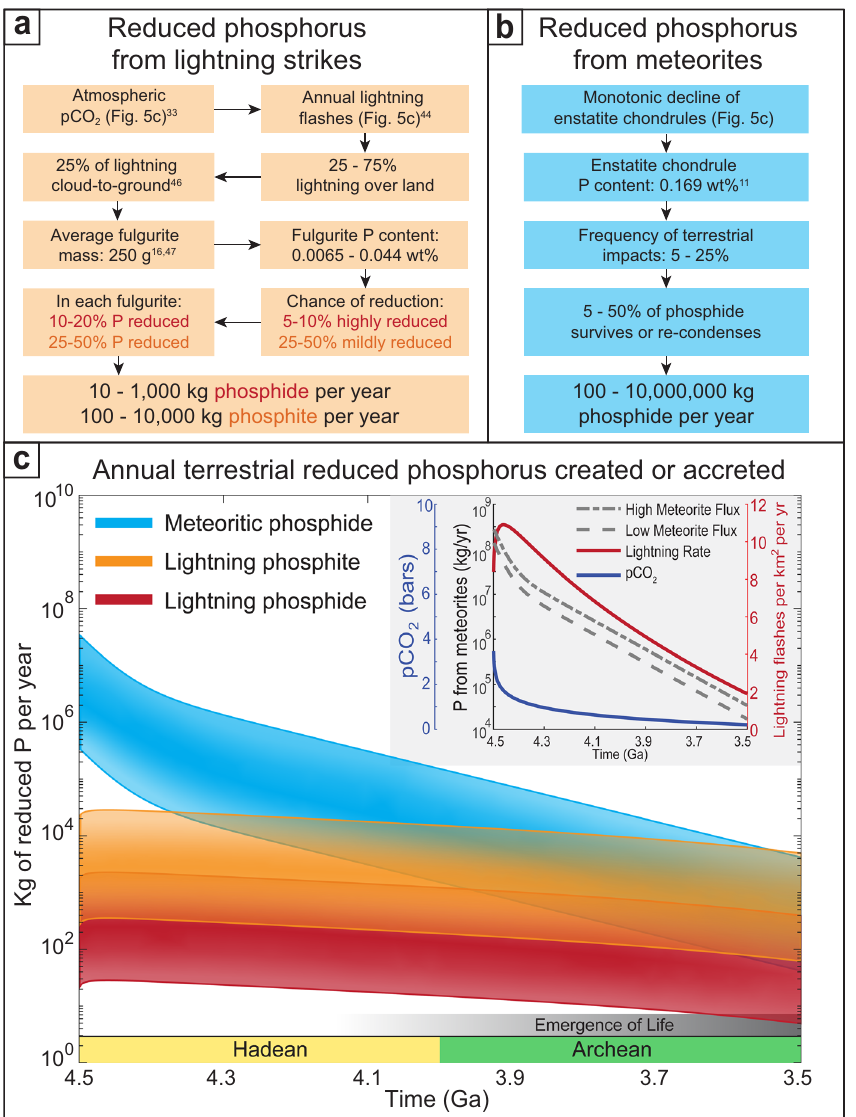
Fig. 5 Method and calculations for the annual amount of reduced phosphorus sourced from lightning strikes vs. meteorite in fl ux during the Hadean and early Archean. a Flowchart showing the steps in calculating the annual formation of reduced phosphorus from lightning strikes on early Earth (see main text and Supplementary Discussion 2). b Flowchart showing the steps in calculating the annual fl ux of reduced phosphorus from meteorites on early Earth (see also main text and Supplementary Discussion 3). c Mass range of reduced phosphorus produced per year from fulgurite-forming lightning strikes and meteorites as calculated in ( a , b ). Inset shows model inputs for atmospheric pCO 2 in bars, lightning strikes per km 2 per year, and annual total P in kg per year from meteorites 11 as a function of